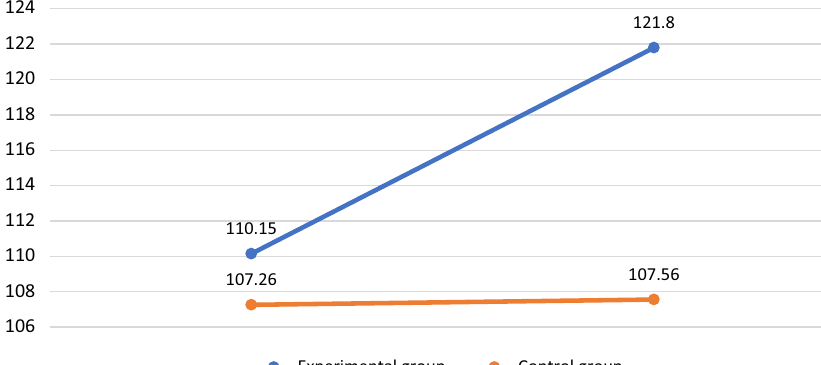
Fig. 3 Teenage EFL students’ English language